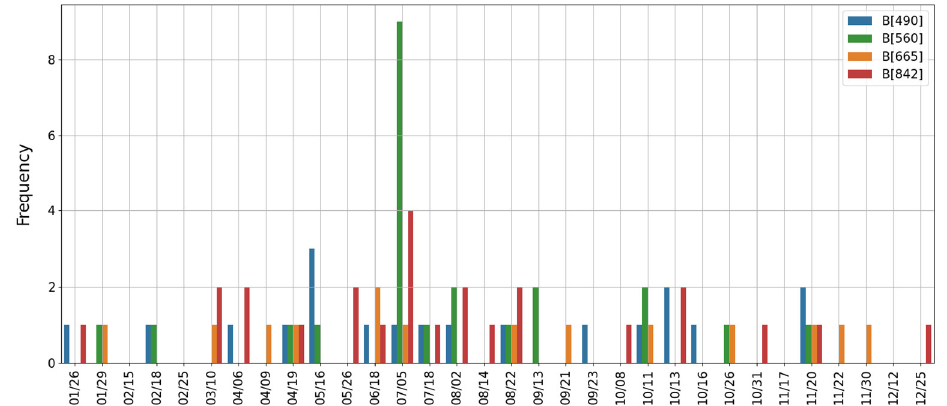
Figure 10. Temporal selection obtained with SFFS for each VNIR spectral band.